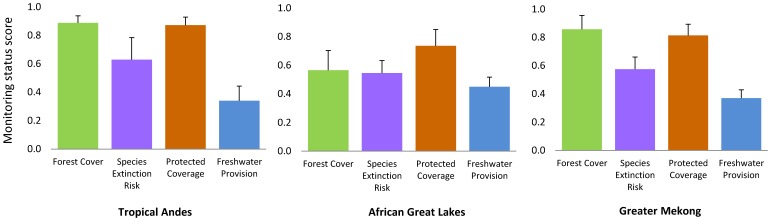
Monitoring status of the indicators, as reported by national experts via questionnaire responses.The mean score and its standard error for each indicator are shown by region. Number of respondent is 36 for Tropical Andes, 46 for African Great Lakes, and 50 for Greater Mekong.